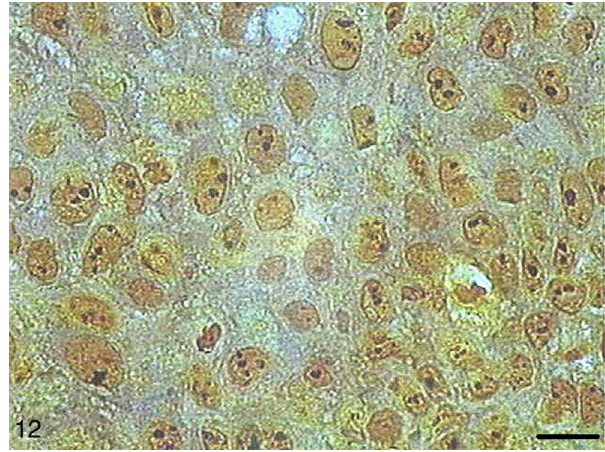
Figure 12 Papilloma with AgNORs. Micrograph of papil- loma with AgNORs forming small clumps present in the nucleus as satellites or occupying the entire nucleolus (AgNOR, bar = 10 (cid:2) m). Number of cells with AgNORs above average. Groups